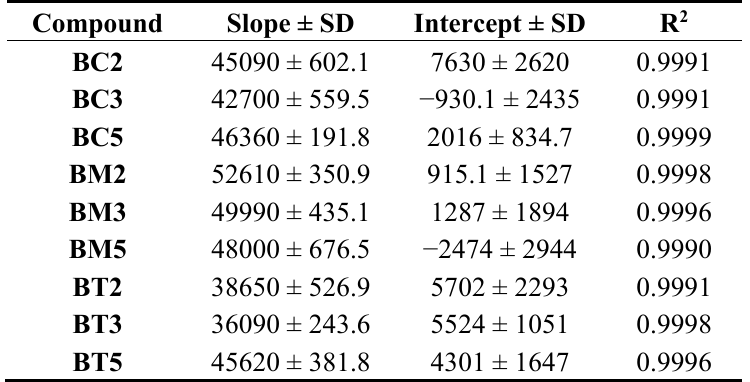
Table 3. Linear regression data for the calibration curve (n = 3).